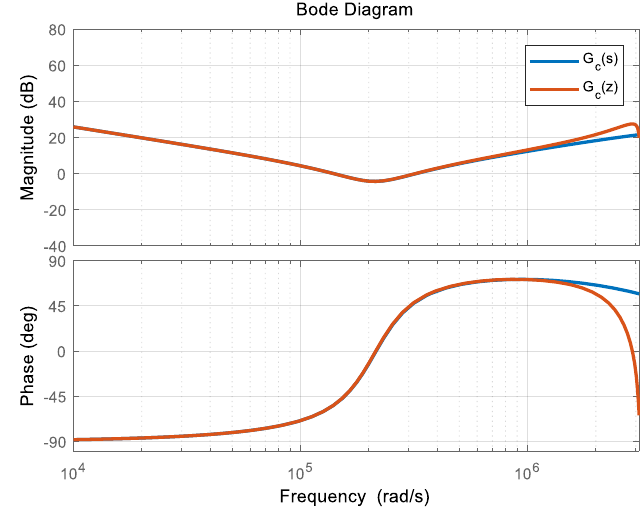
Figure 5. Load regulation by real and complex zeros-based compensators.